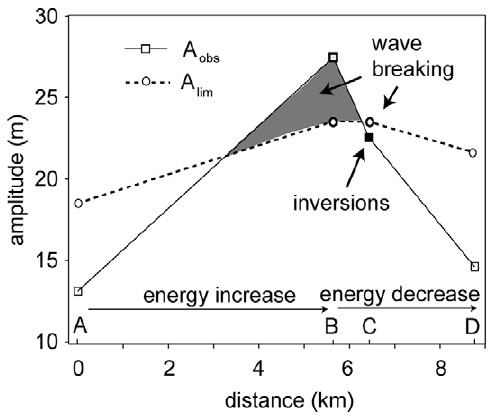
Figure 5. Increase and decrease of ISW amplitude with propagation distance of a shear limited wave observed on 26 October 2010. The grey area denotes simulated ( A obs /A lim . 1), the black square indicates observed (density inversions) wave breaking.